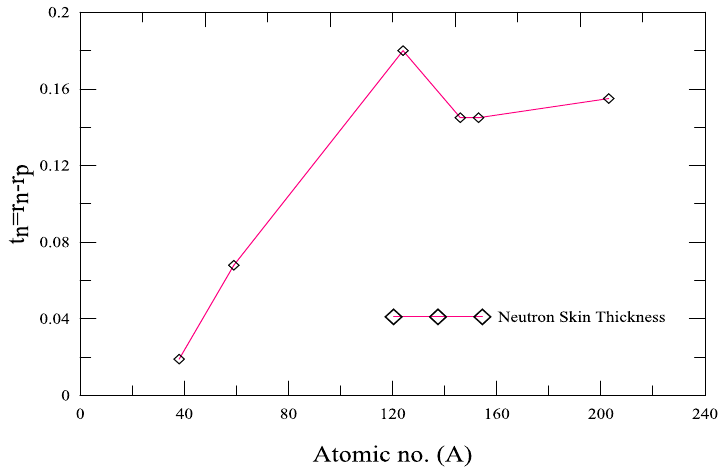
Fig 3: The neutron skin thickness for 38 Ar, 59 Co, 124 Sn, 146 Nd, 153 Eu and 203 Tl nuclei using SkM* Skyrme parameterization.